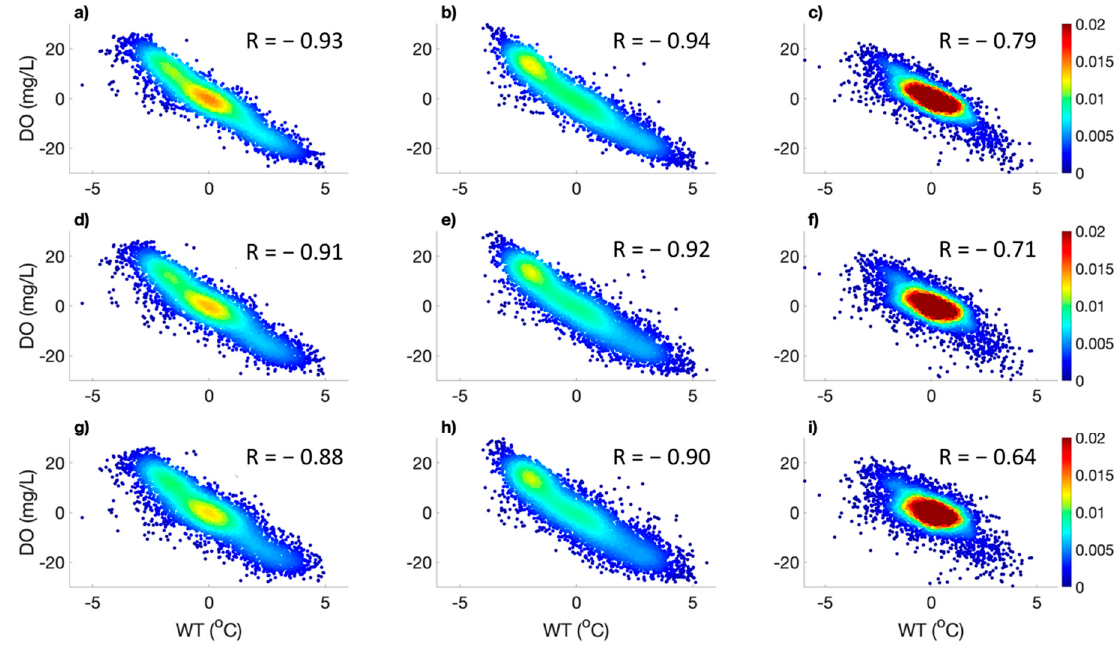
Figure 5. Density scatterplots of de-seasonalized DO against water temperature for a large watershed ( a , d , g ); a medium watershed ( b , e , h ); and a small watershed ( c , f , i ) and for three different lags: 1 day ( a – c ), 2 days ( d – f ), and 3 days ( g – i ). Correlation coefficients for each case are also shown.